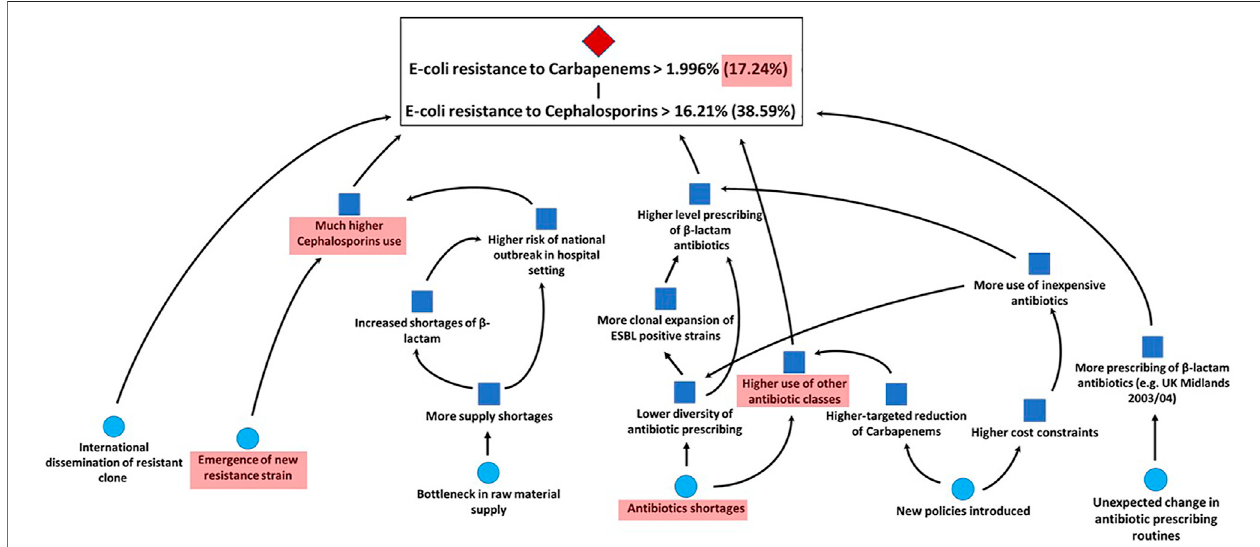
FIGURE5 | Combined conditional exceedance probabilities for the50 th and 95 th quantiles (per weightingscheme) with fi ttedcopulas through the tail dependence coef fi cient for u between 0.5 and 1.